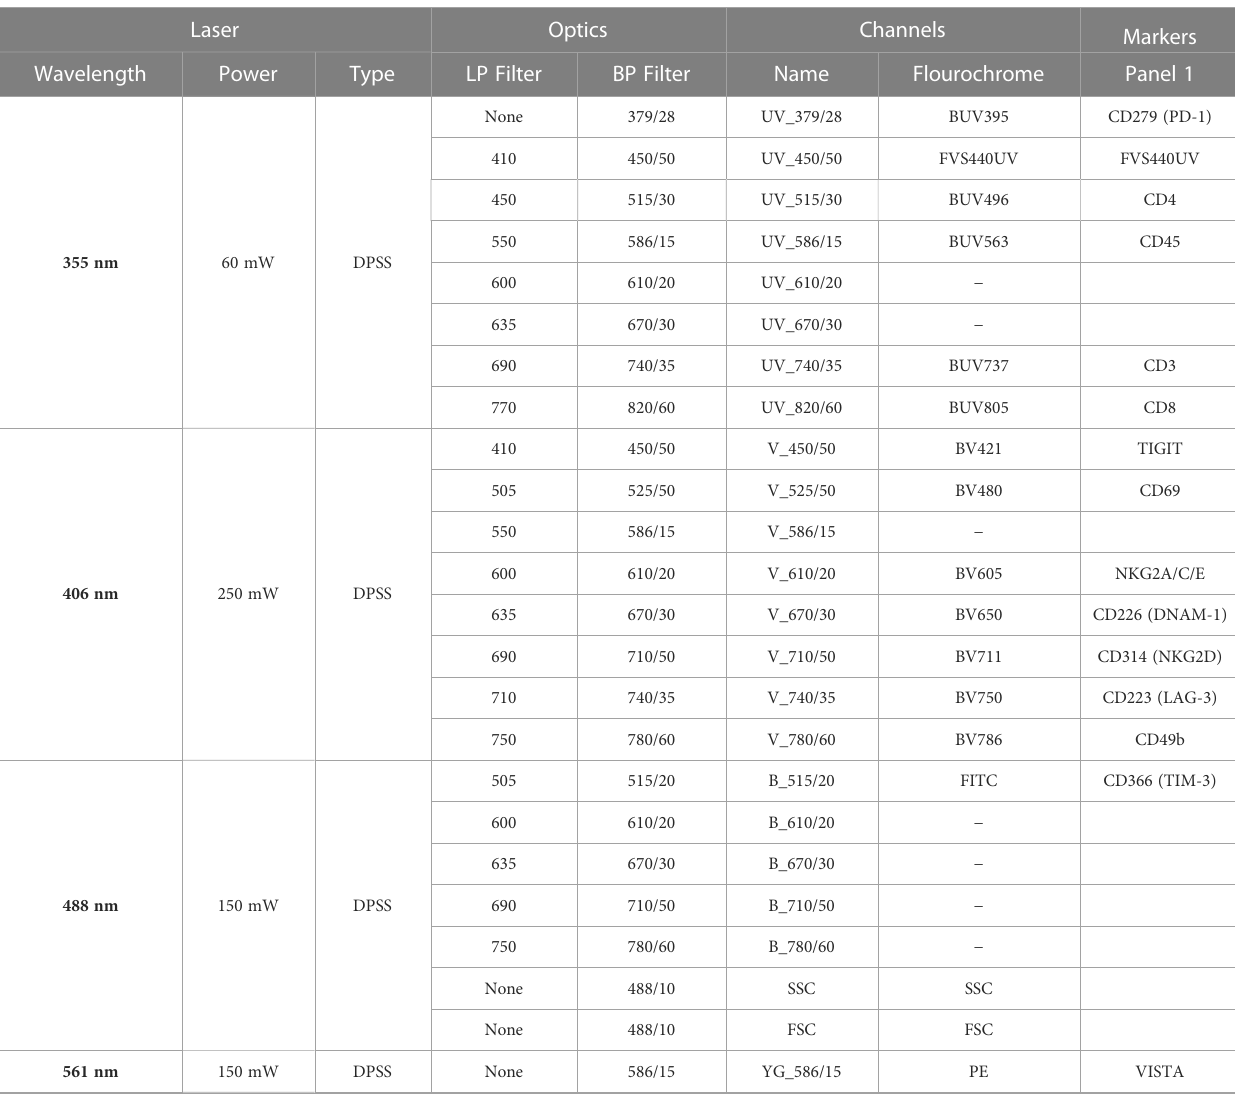
TABLE 4 Instrument Con fi guration for Panel